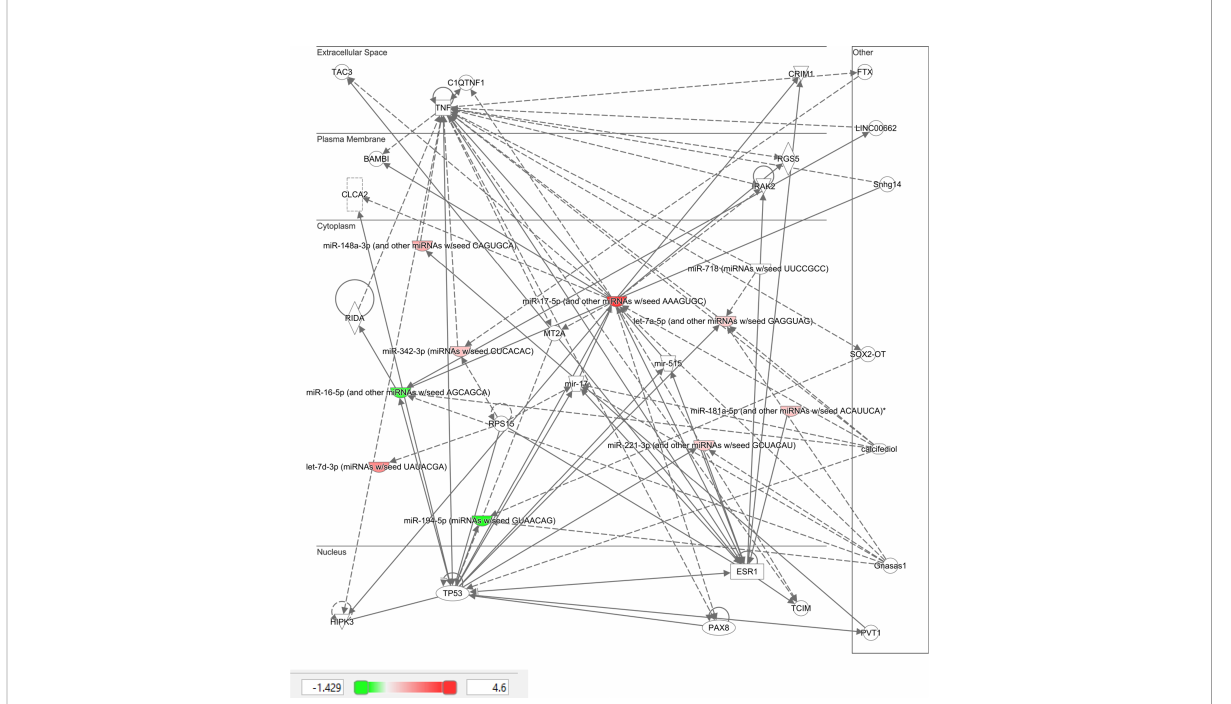
FIGURE 4 Ingenuity pathway analysis of top 10 miRNA that showed differential expression in type 2 diabetic subjects in response to